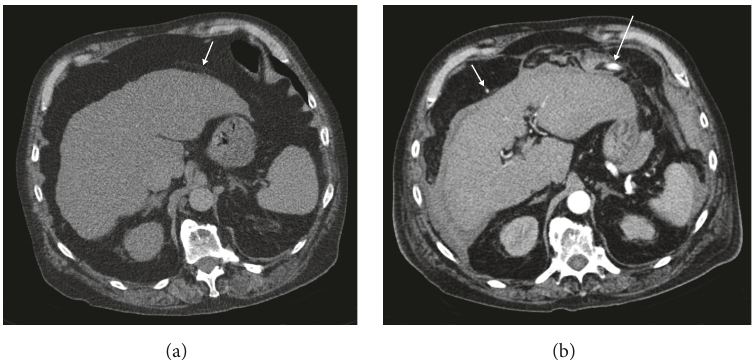
Figure 1: Computed tomography (CT) images. CT on admission (a) demonstrating liver cirrhosis with the greater omentum in the upper abdomen and tiny omental vessels (arrow) in the left upper abdomen. Arterial phase of contrast-enhanced computed tomography image six days later (b) with haemoperitoneum, segmental dilatated omental artery in the left (arrow), and spot of enhanced tiny omental artery in the right upper abdomen (small arrow).